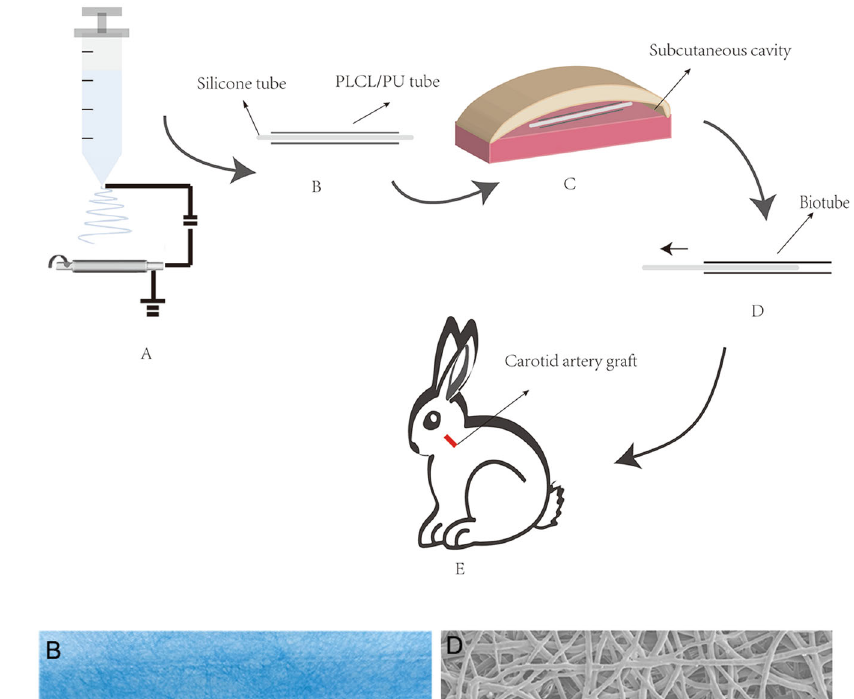
Fig. 1 Sketch map of